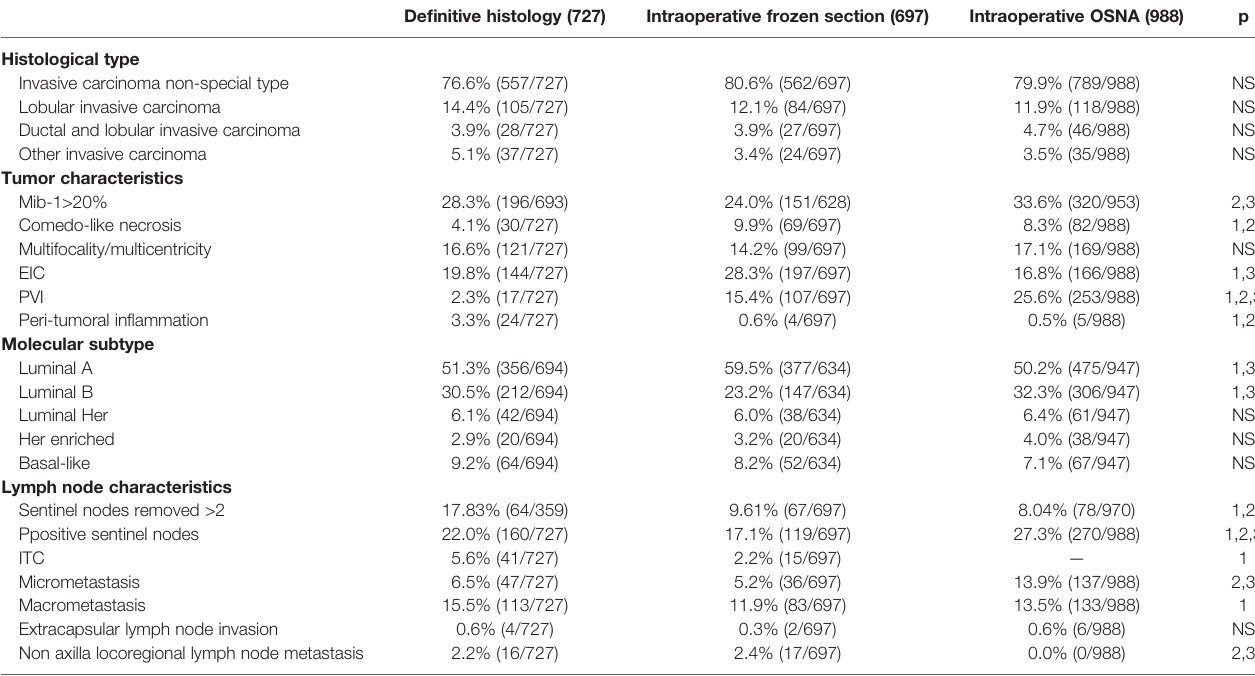
TABLE 2 | Tumor characteristics considering the three groups (de fi nitive histology, intraoperative frozen section, and